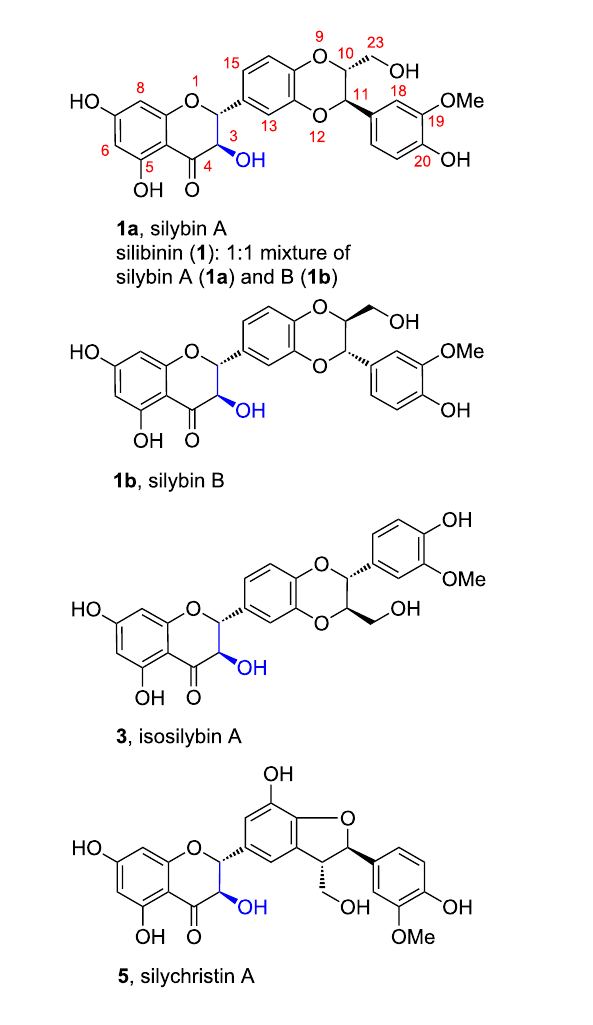
Figure 1: Structures of silibinin, isosilybin, and silychristin, and hydnocarpin-type flavonolignans.